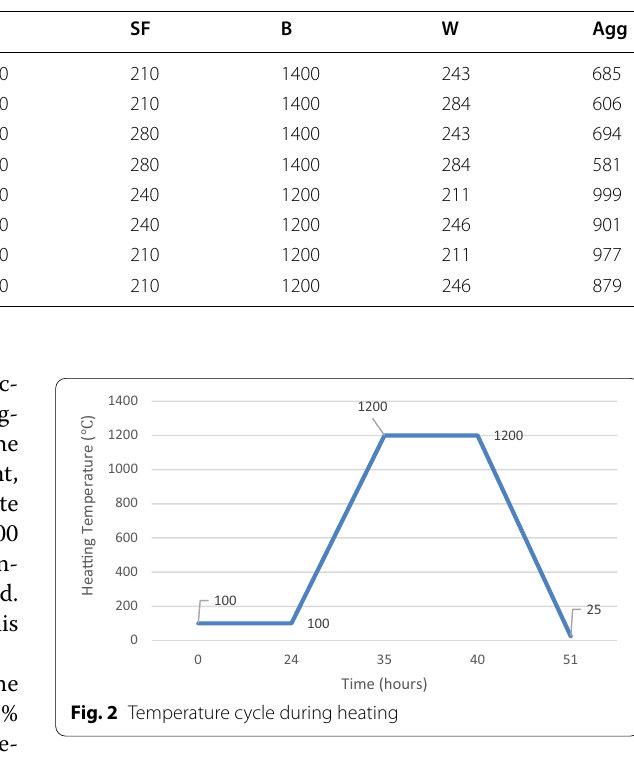
Table 4 Mix design proportioning Mixture